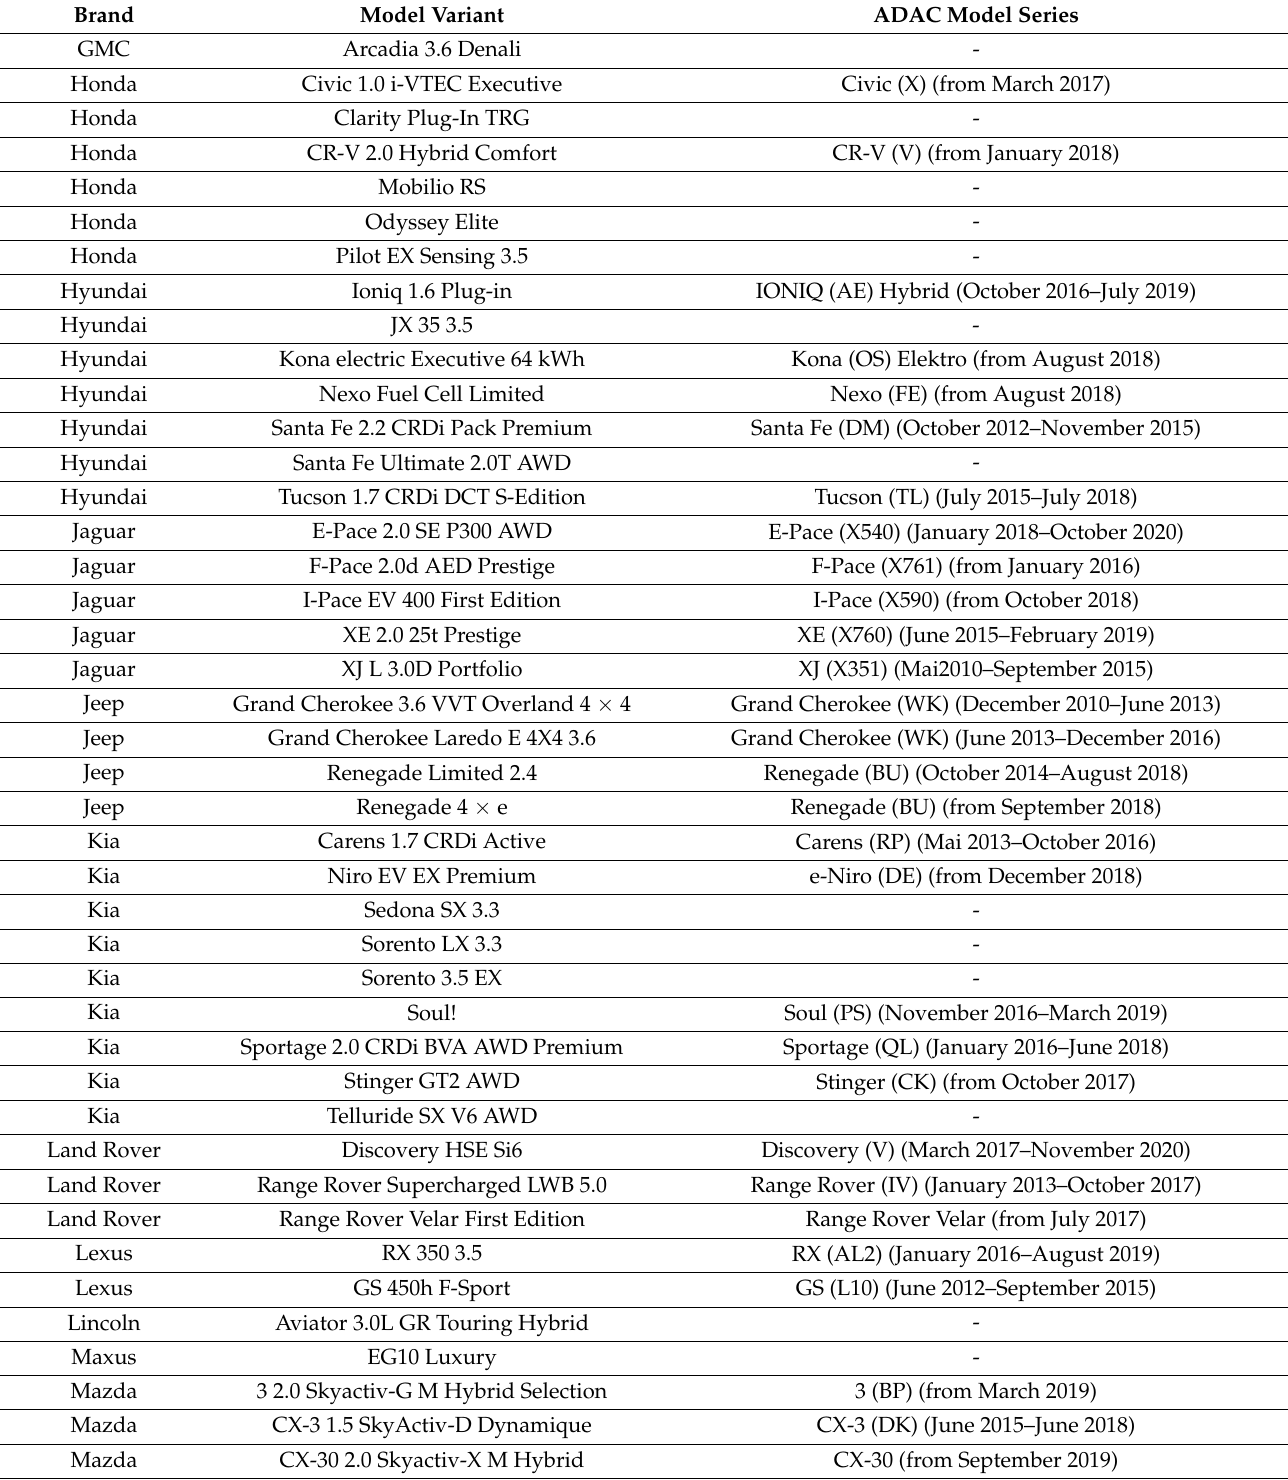
Table A12. Overview of the employed vehicles for the parametric mass model (Part